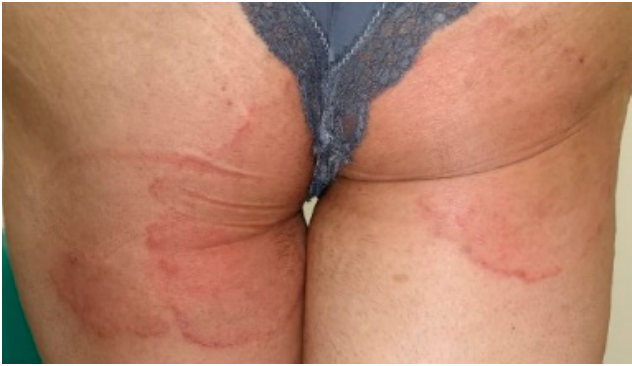
Figure 3. Tinea corporis und tinea glutealis due to T . mentagrophytes VIII in a woman originating from Iraq and living for a long time in Germany. Typical inflammatory and itching erythematosquamous plaques were observed involving the buttocks, the groin and the thighs. Patient No. 14. Laboratory number of the fungal isolate: 205667/2019.